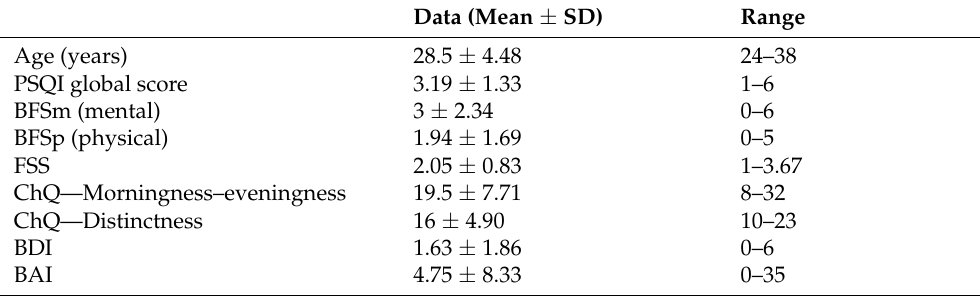
Table 1. Demographic data.